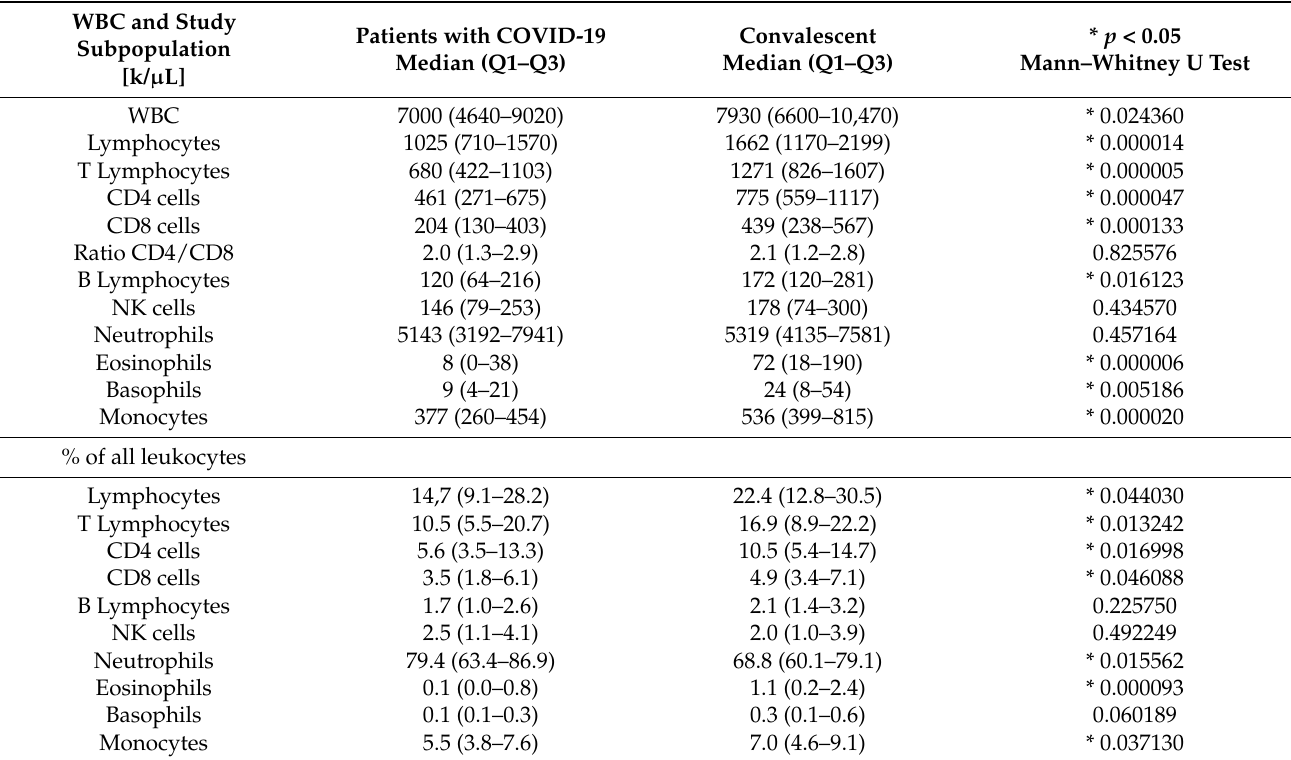
Table 2. Differences in the median white blood cell (WBC) count and leukocyte and main lymphocyte subpopulation counts between patients with COVID-19 and convalescent COVID-19 patients.